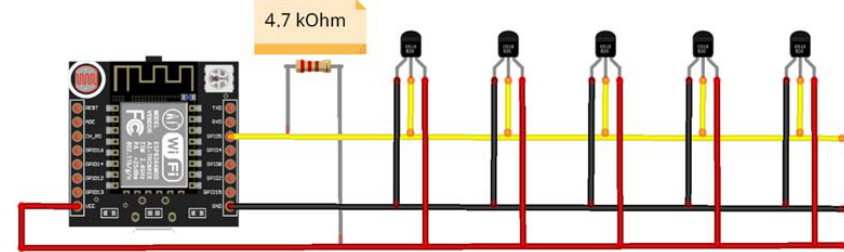
Figure 6. 1 ‐ wire bus scheme .